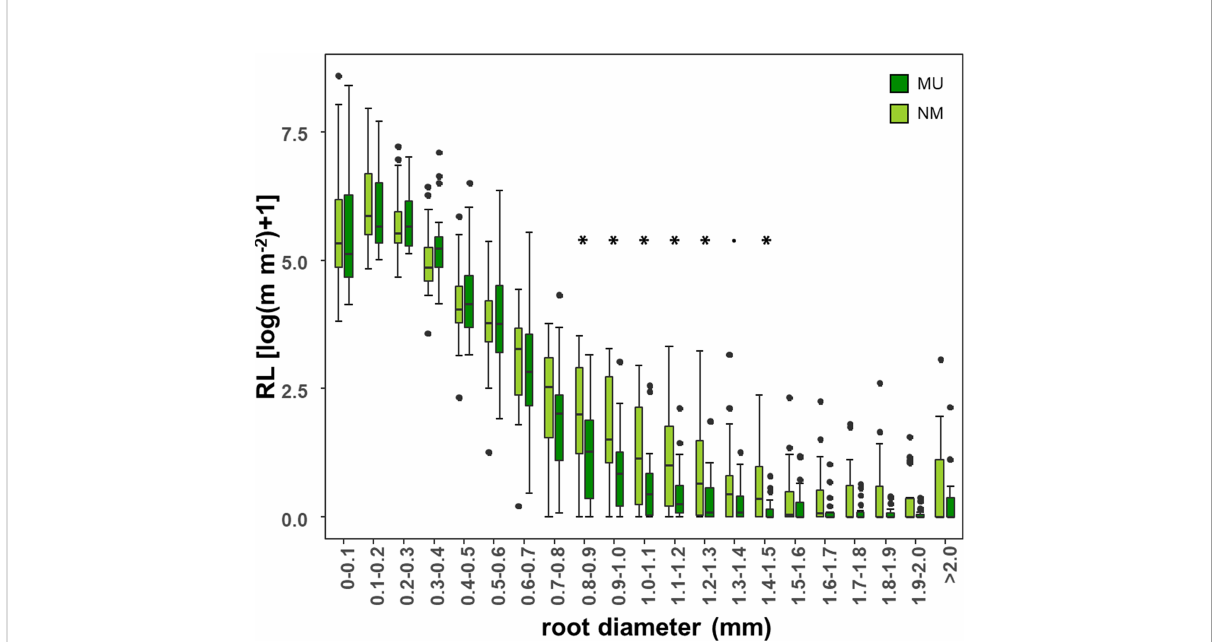
FIGURE 5 Comparison of root length (RL) within each class of root diameter at the community-level between control (NM; no mulching) and mulching- treated (MU) areas in the 10 sampled plots. RL is plotted as logarithmic only for facilitating the visualization of smaller values. The boxplot indicates the median (line in the middle of the boxes), the interquartile range (boxes), 1.5 times the interquartile range (whiskers) and outliers (circle). Results of the Wilcoxon test are reported only if signi fi cant at p < 0.05 (asterisk) or p < 0.1 (point).